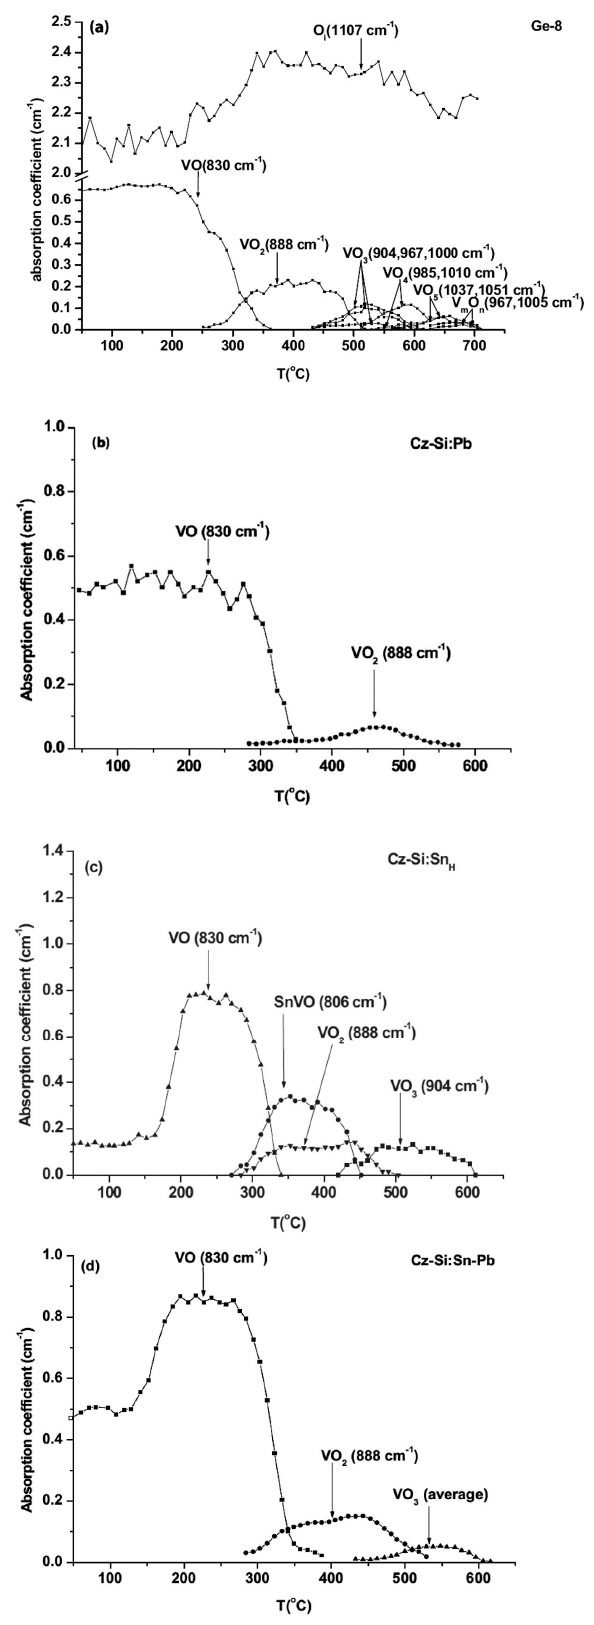
Figure 2. Thermal evolution of the various VO n defects for the Ge-8 sample ( a ), and the Cz–Si:Pb ( b ), Cz–Si:Sn H ( c ), and Cz–Si:SnPb ( d ) samples. Reproduced with permission from [102,127]. American Institute of Physics.